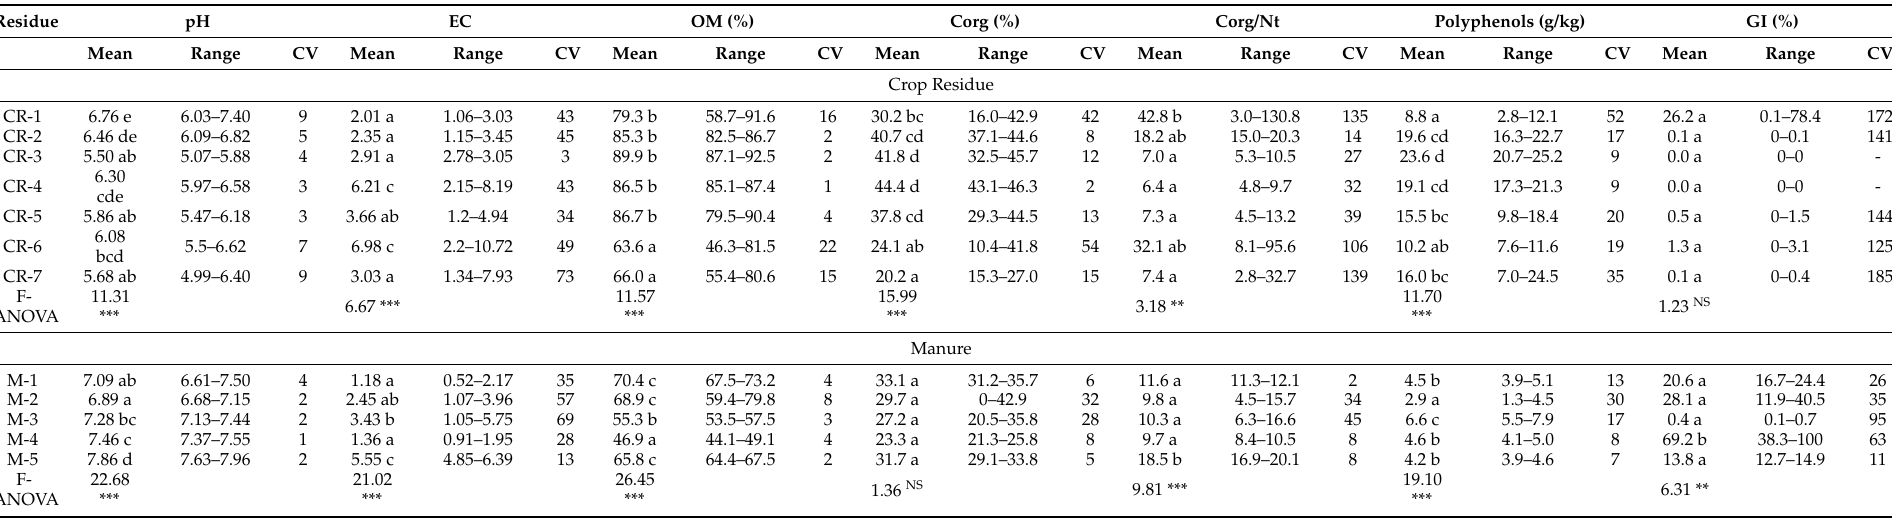
Table 2. Physicochemical, chemical, and biological parameters of the agro-livestock wastes (on a dry weight